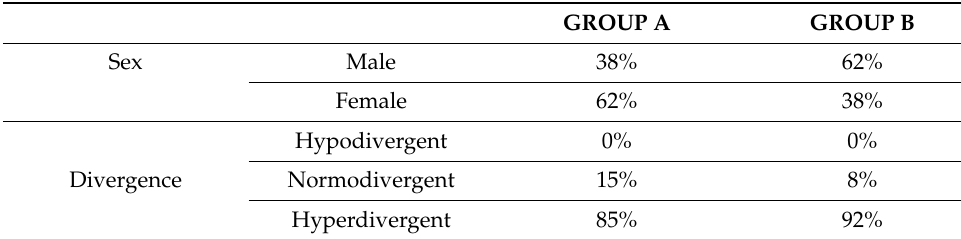
Table 1. Distribution by age and divergence of the sample